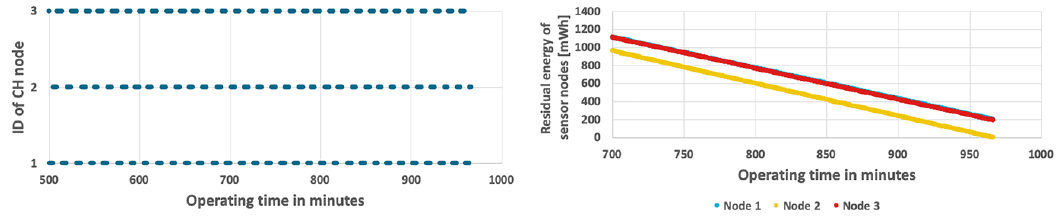
Figure 17. Energy consumption by sensor nodes for FDCR algorithm with a variable number of detected